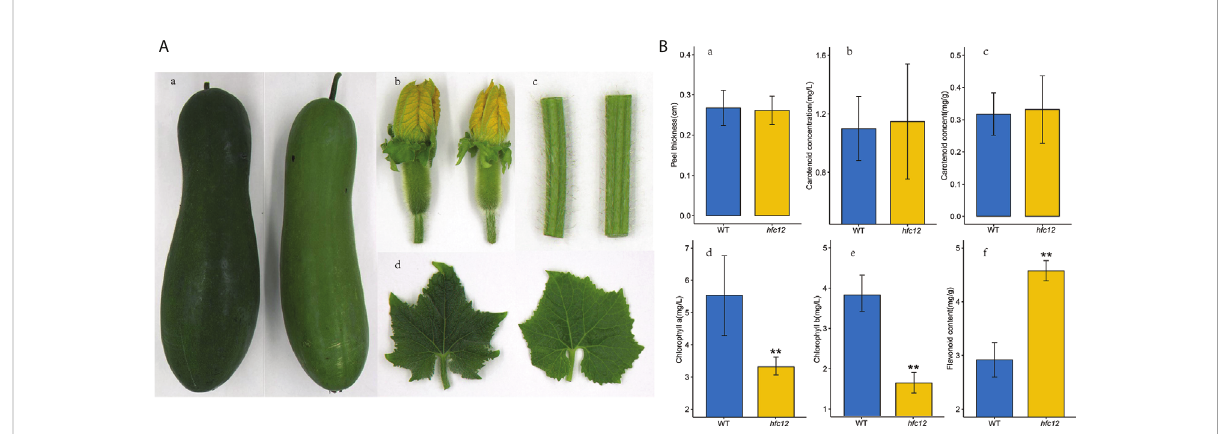
FIGURE 1 Phenotypic characterization and physiological indicators of WT and hfc12 . (A) Phenotypic characterization of fruits at 40 DAP (a), fl owers (b), stems (c), and leaves (d) of WT (left) and hfc12 (right). (B) Physiological indicators including peel thickness (a), carotenoid concentration (b),